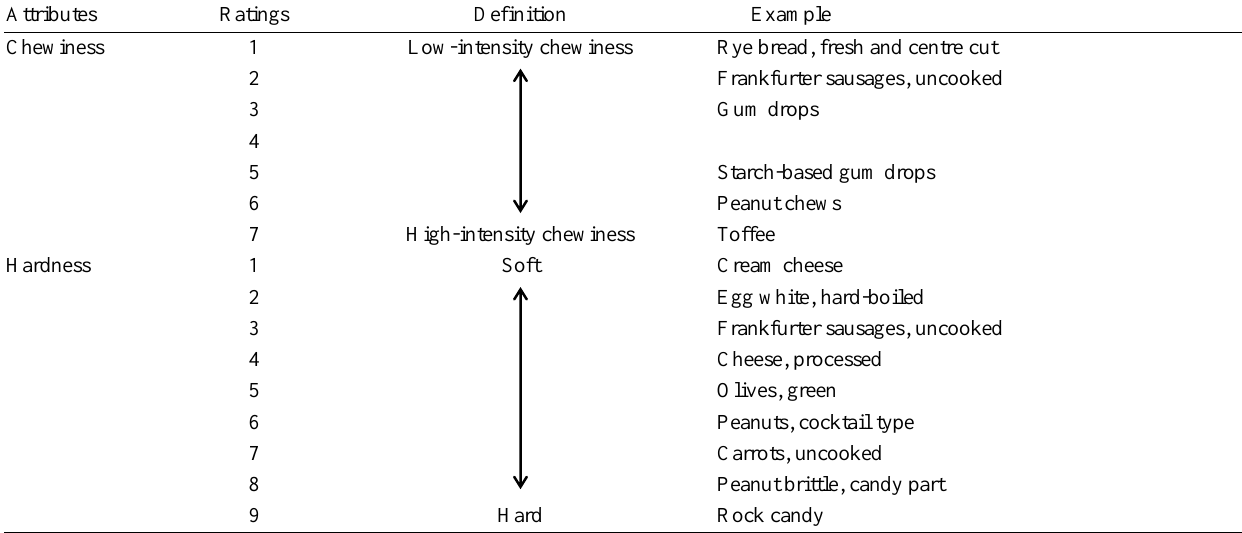
Table 1. Scales of ‘chewiness’ and ‘hardness’ defined by ISO11036:1994